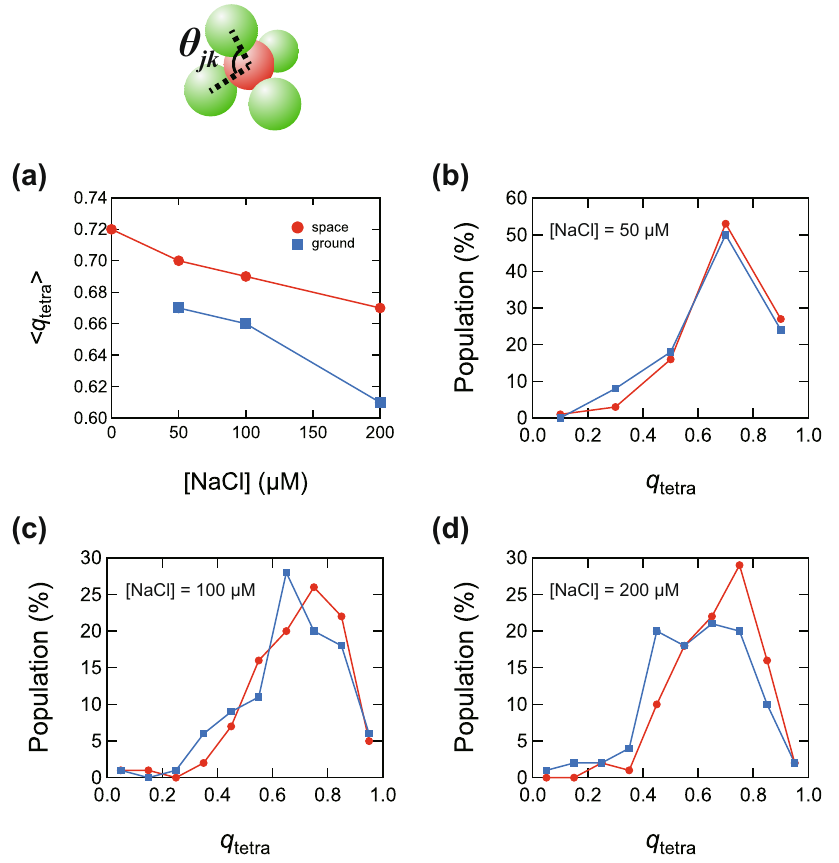
Fig. 6 Comparison of the bond orientational order parameter q tetra for PS particle tetrahedra produced by the space and ground experiments. a Plot of mean < q tetra > versus [NaCl], b – d distribution of q tetra at [NaCl] = 50 μ M, 100 μ M, and 200 μ